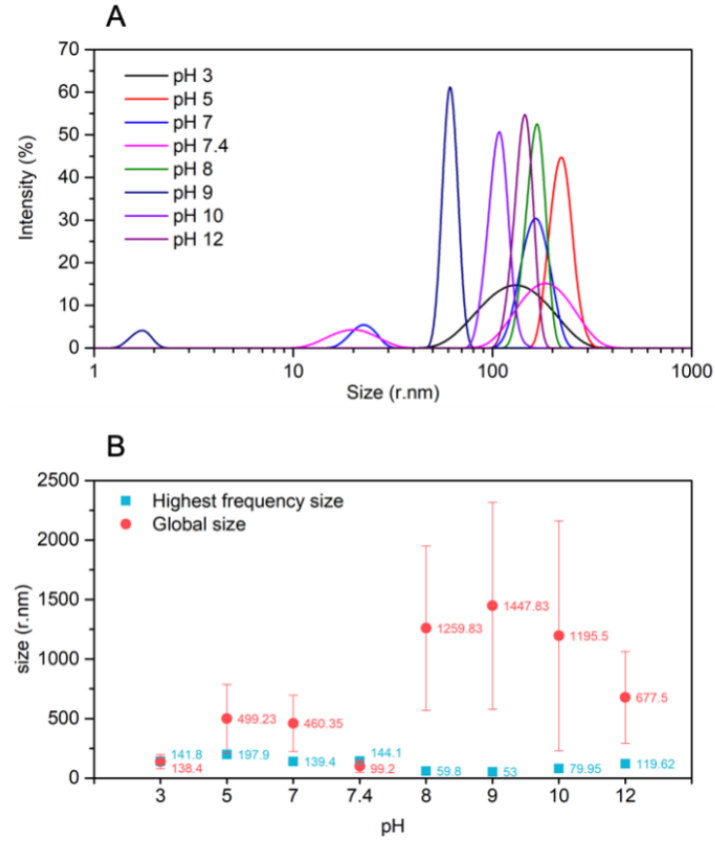
Figure 3. pH stability study of CMCht/PAMAM with GDNF NPs. ( A ) Size distribution from 1 to 1000 nm (radii) of CMCht/PAMAM NPs with GDNF at different pH values. ( B ) Highest frequency radii size value vs. global radii size average value.